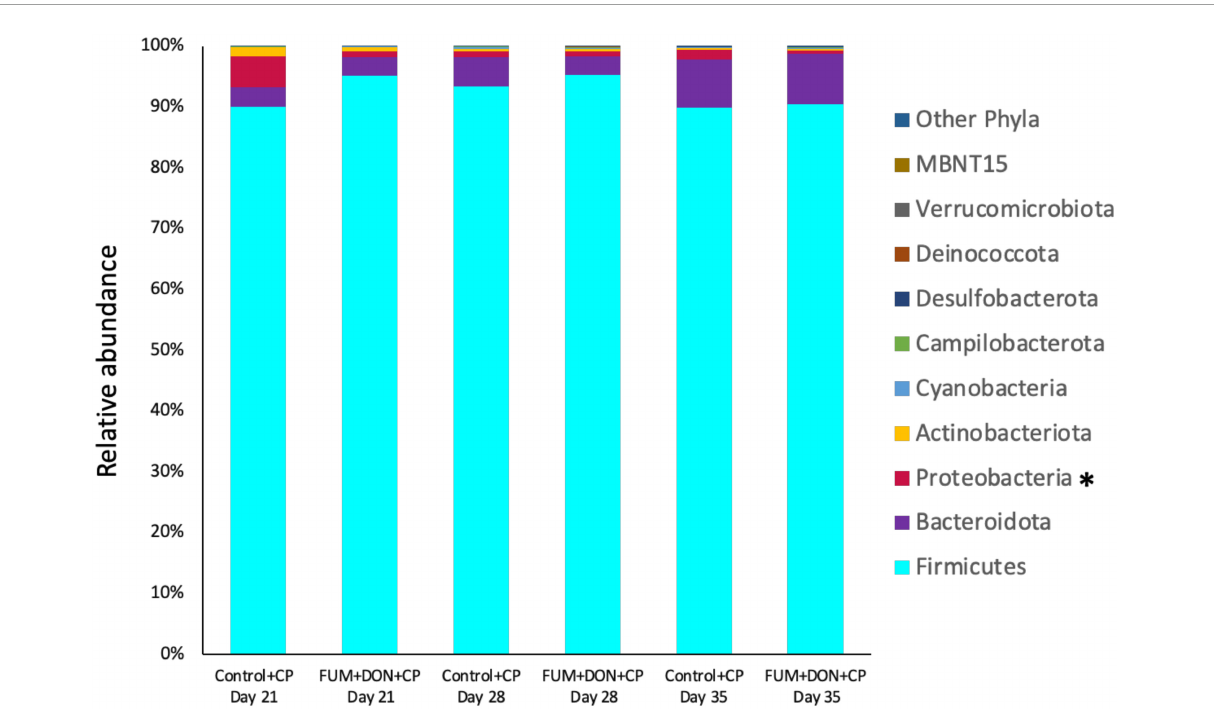
FIGURE3 Effect of subclinical fumonisins (FUM) and deoxynivalenol (DON) contamination on relative abundance of microbiome composition at phylum level. Broilers were fed control or mycotoxin (FUM 3 mg/kg diet + DON 4 mg/kg diet). All birds received 1 × 10 8 CFU/bird of C. perfringens on d 19 and 20. Cecal digesta was analyzed for microbiome composition at phyla level using 16S rRNA sequencing at 1, 7, and 14 days post-infection. Asterisk denotes significant difference ( ∗ P <